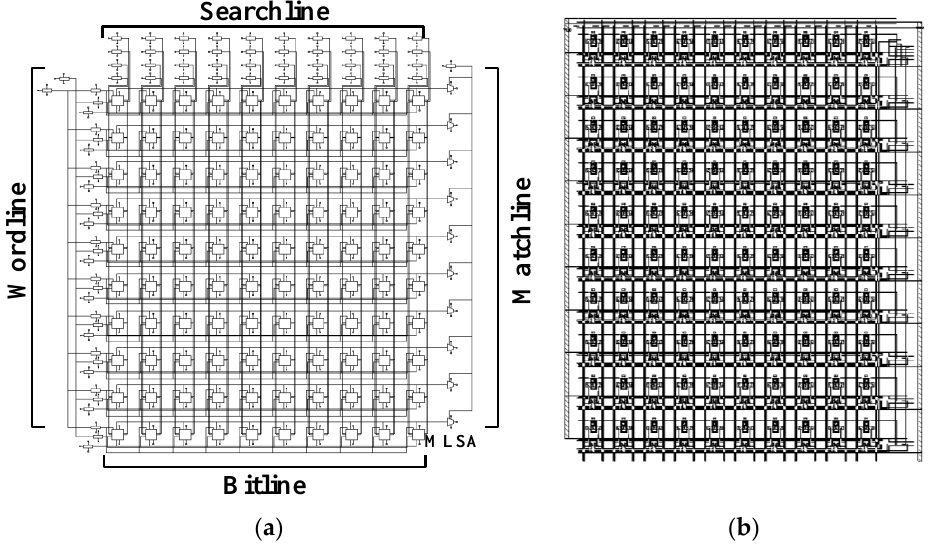
Figure 11. ( a ) Schematic and ( b ) layout of a 10 × 10 array design.